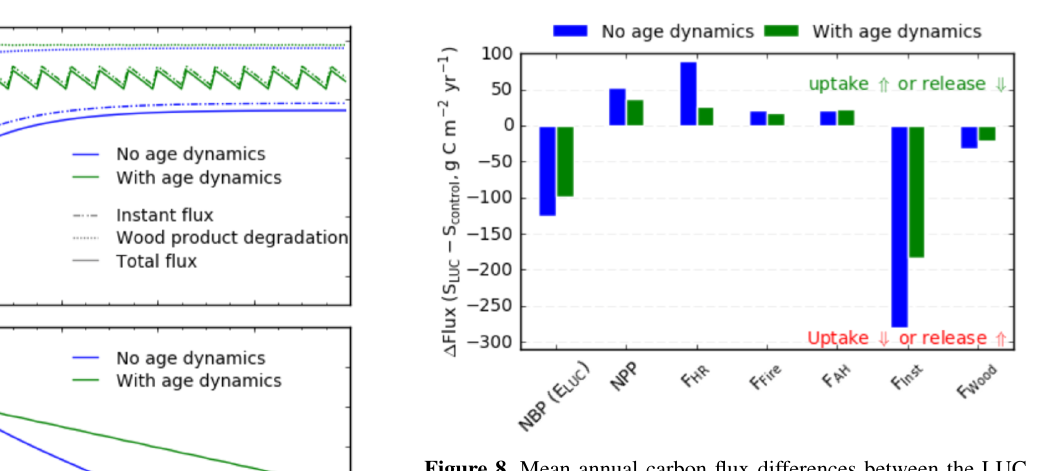
Figure 8. Mean annual carbon flux differences between the LUC and control simulations over 100 years for an annual forest– cropland turnover with 5% of the grid cell area for two model con- figurations: without (blue) and with sub-grid age dynamics (green). Positive (negative) values indicate contributions to enhanced carbon sink (source) in LUC simulation compared to the control one, either by stronger (weaker) carbon uptake or smaller (stronger) carbon re- lease. E LUC is shown as a negative value here, i.e. the LUC simu- lation has a lower NBP than the control one, indicating an effect of net carbon source by